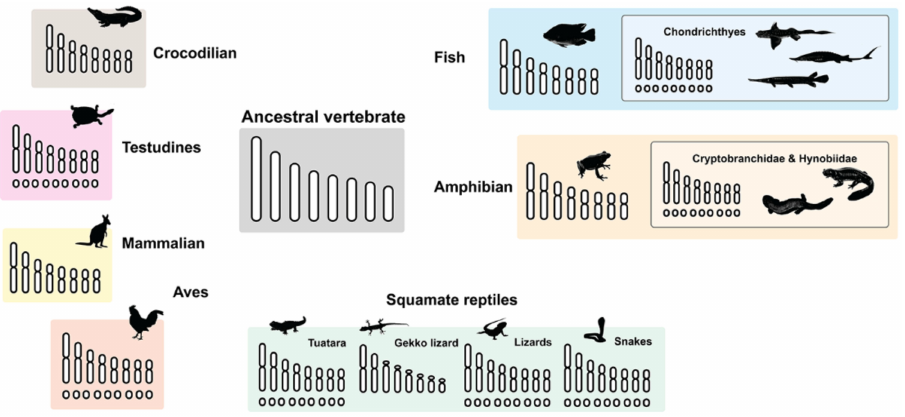
Figure 1. Microchromosome distribution of vertebrates and karyotypic